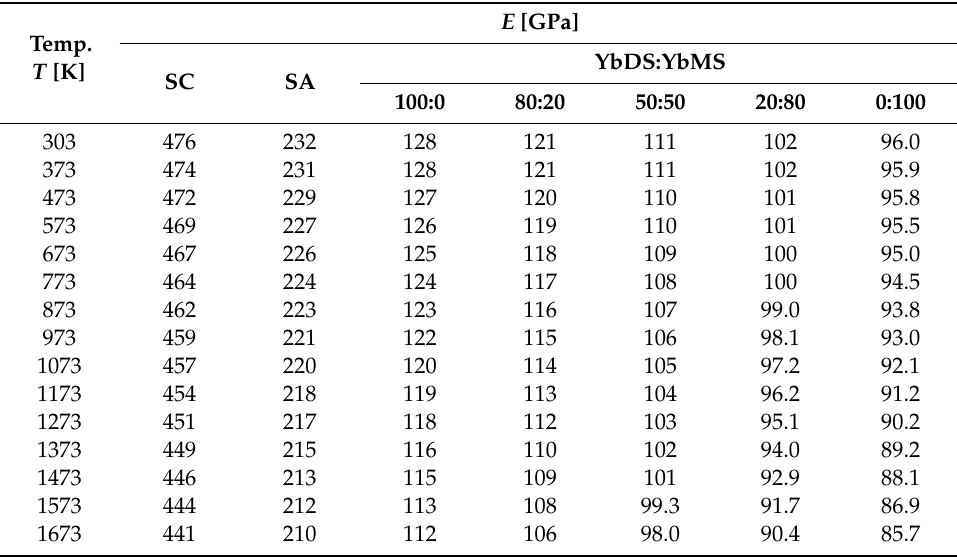
Table 2. Young’s moduli ( E ) of isotropic elastic